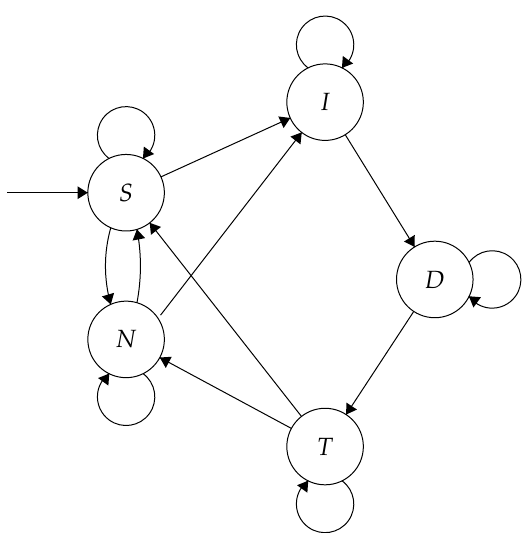
Figure 12. Gunshot detection model state diagram showing possible movement between five states: silence (S) , noise (N) , impulse (I) , decay (D) , and tail (T)